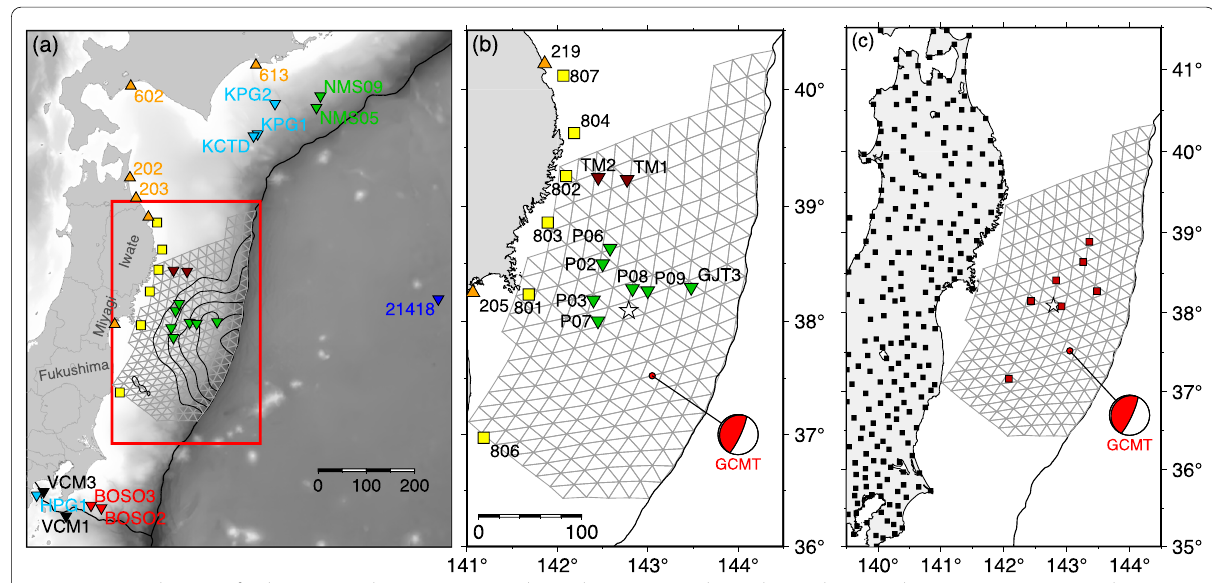
Fig. 1 a Station locations for the tsunami observation. Inverted triangles, squares, and triangles are the ocean-bottom pressure gauges, the offshore GPS buoys, and near-shore seafloor wave gauges, respectively. The colors of the symbols indicate agencies owning each dataset. b Close-up around the Off-Tohoku region. The white star denotes the epicenter of the Tohoku-Oki earthquake (Suzuki et al. 2012). c The location of the onshore and offshore geodetic stations used in the present study. Black and red squares denote inland GPS and seafloor geodetic observatories, respectively. Small triangles represent the configuration of the triangular subfaults used for the